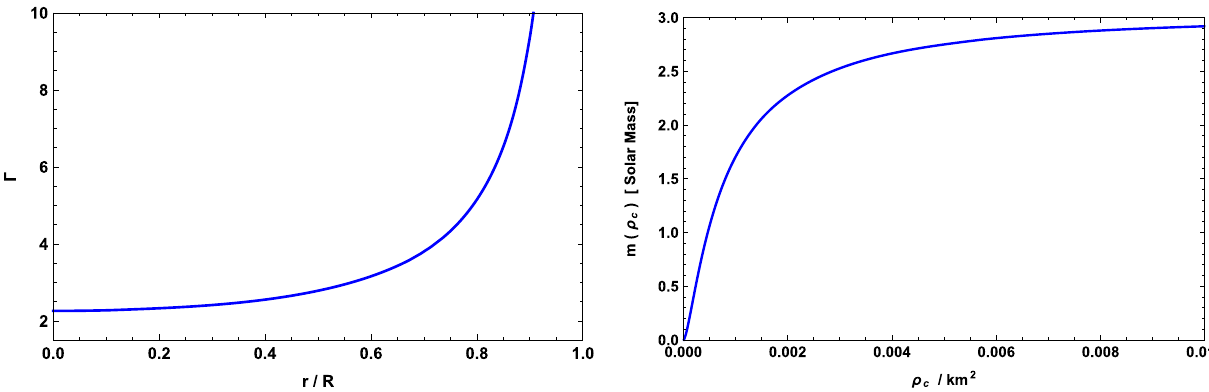
Fig. 6 The adiabatic index and mass-central density curves are plotted against r / R and ρ c by taking the same values as in Fig. 1 for PSR J1903+327